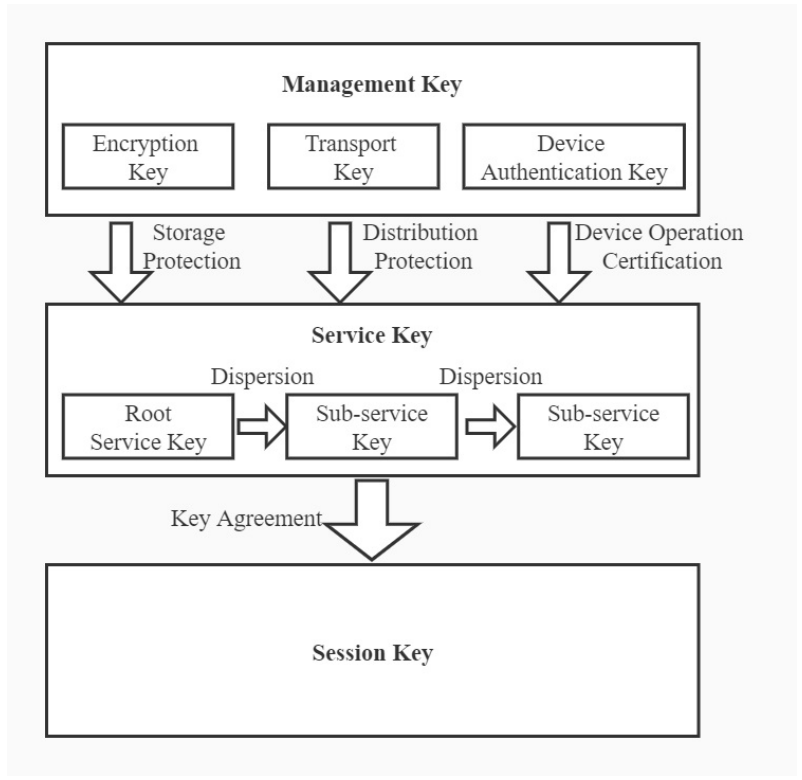
Fig. 2 Lightweight hierarchical key